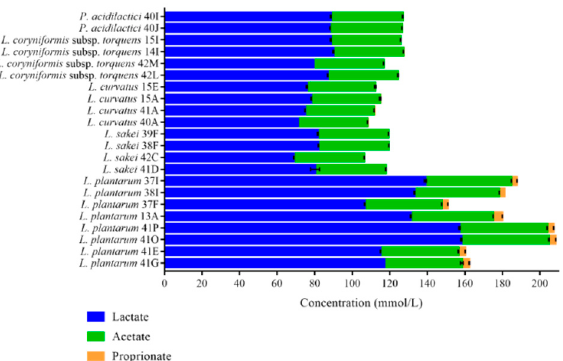
Figure 3. Concentration of organic acids (mmol/L) in the CFS produced by 22 selected LAB species. The data indicates mean ± standard deviation of three independent experiments.